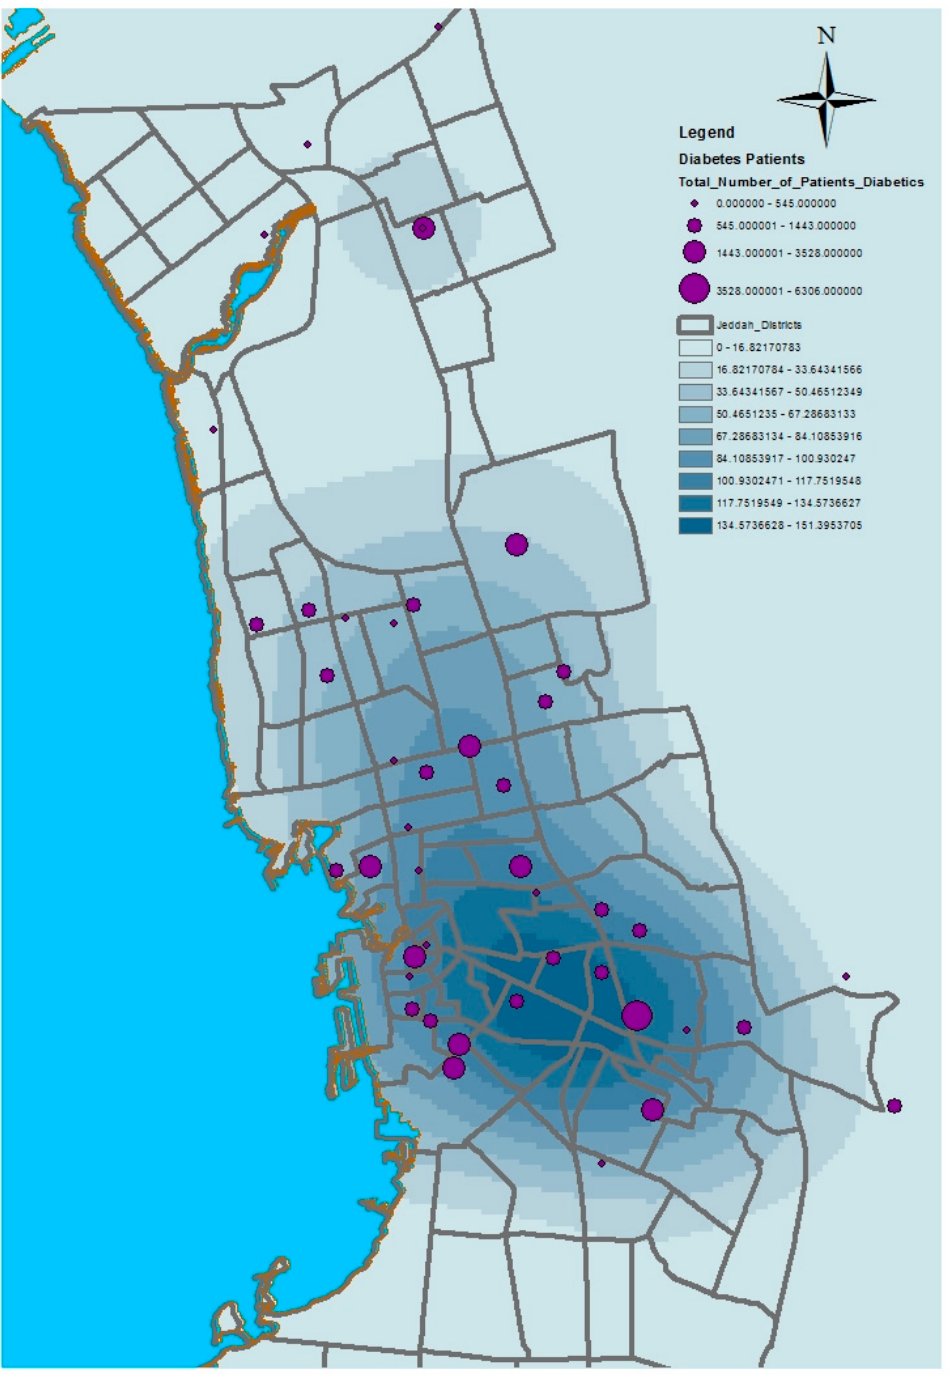
Figure 9. Kernel density for diabetes patients.